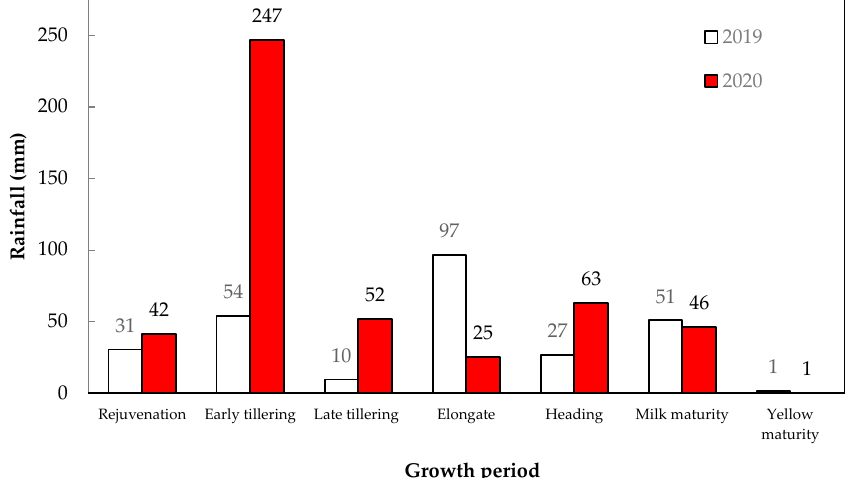
Figure 1. Precipitation at each growth period of rice. The total precipitation during the rice growth period in 2019 and 2020 was 270 mm and 475 mm, respectively. The precipitation was mainly concentrated in the elongation period in 2019 and the early tillering period in 2020.